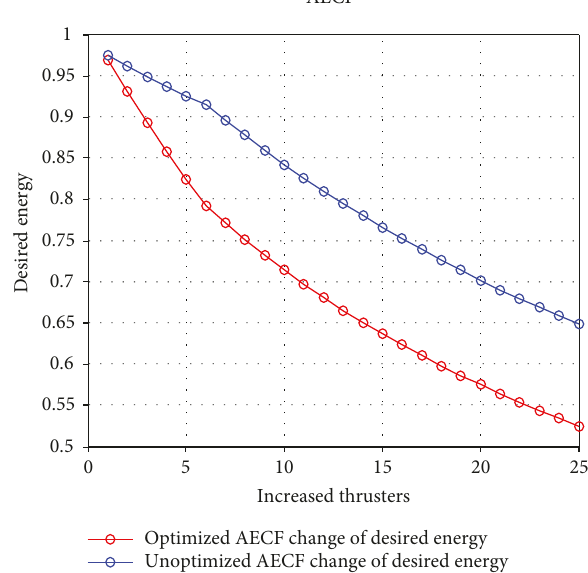
Figure 6: Comparison of optimization e ff ects.